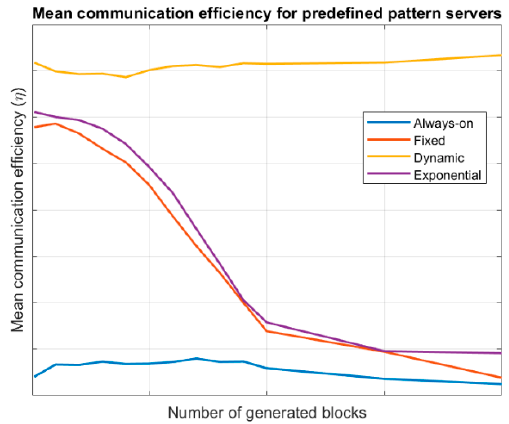
Figure 3. Mean communication efficiency for predefined pattern servers.